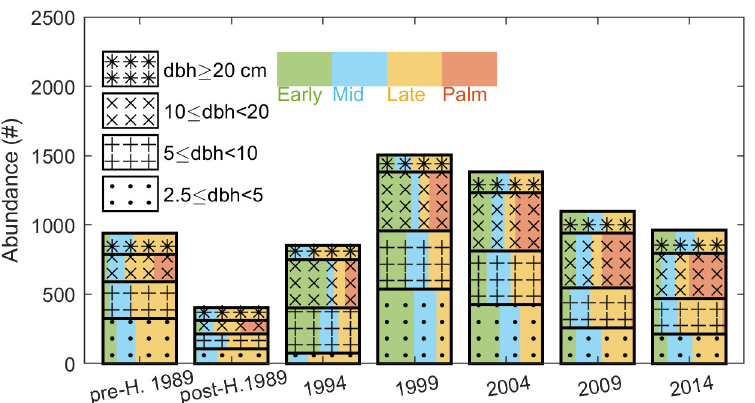
Figure 6. Bar chart of stem abundance (#) in each census at Bisley Experimental Watersheds, Luquillo, Puerto Rico. The stem abundance is calculated as the total number of stems in the 85 plots that were established in pre-Hugo 1989. For each census along the horizontal axis, the stem abundance is composed of four diameter (DBH) classes identified by the stacked bar pattern fills, and within those are the four plant functional types (PFTs) represented in colors.